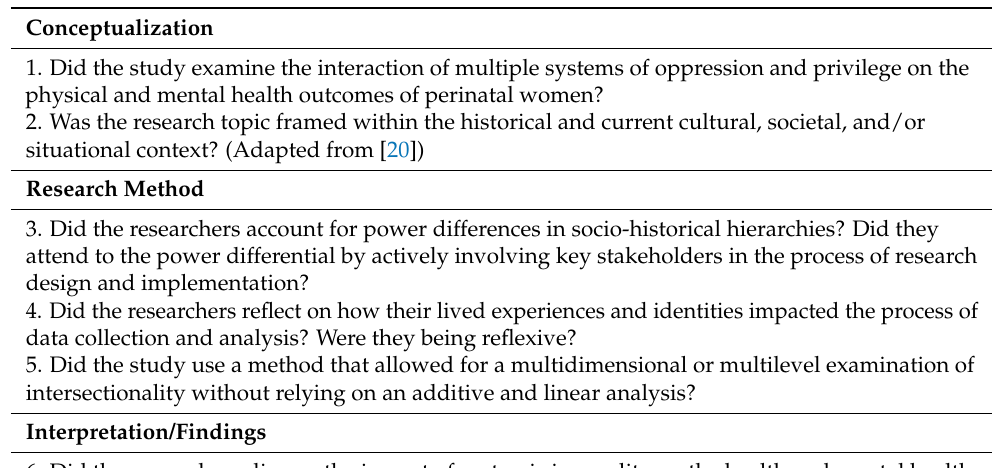
Table 1. Research